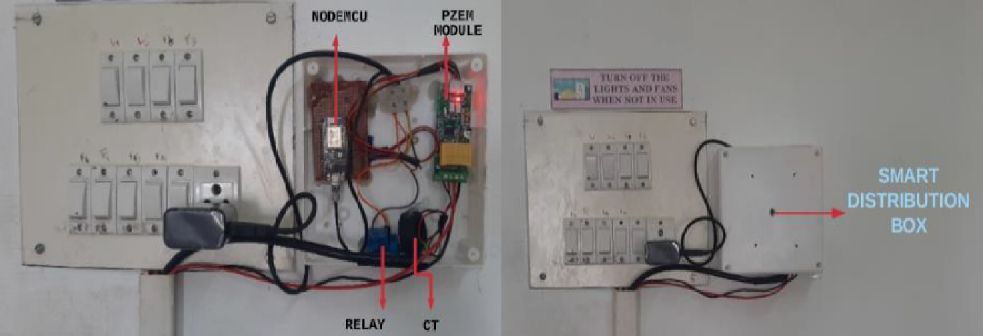
Figure 14. Implemented hardware setup at Renewable Energy Laboratory.